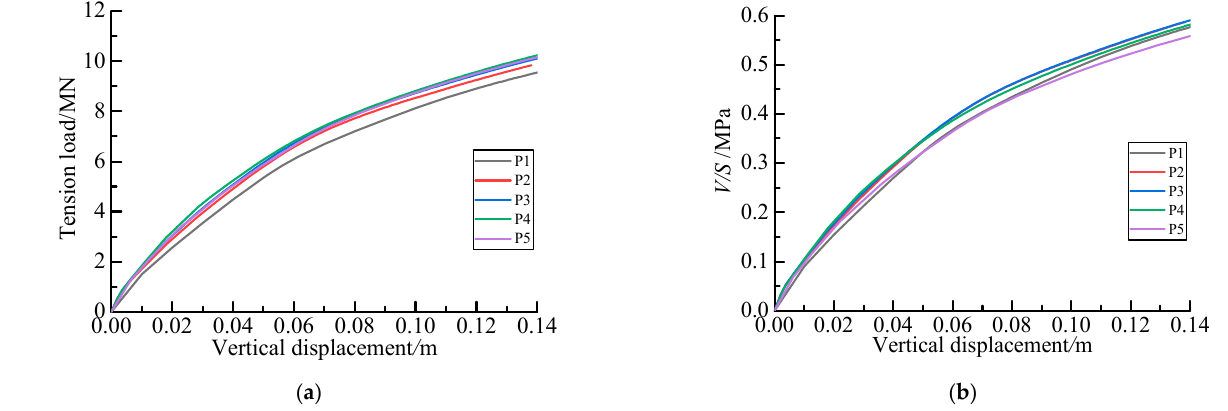
Figure 17. Uplift bearing characteristics of helical pile with different pitches. ( a ) Load-displacement curves; ( b ) V/S -displacement curves.